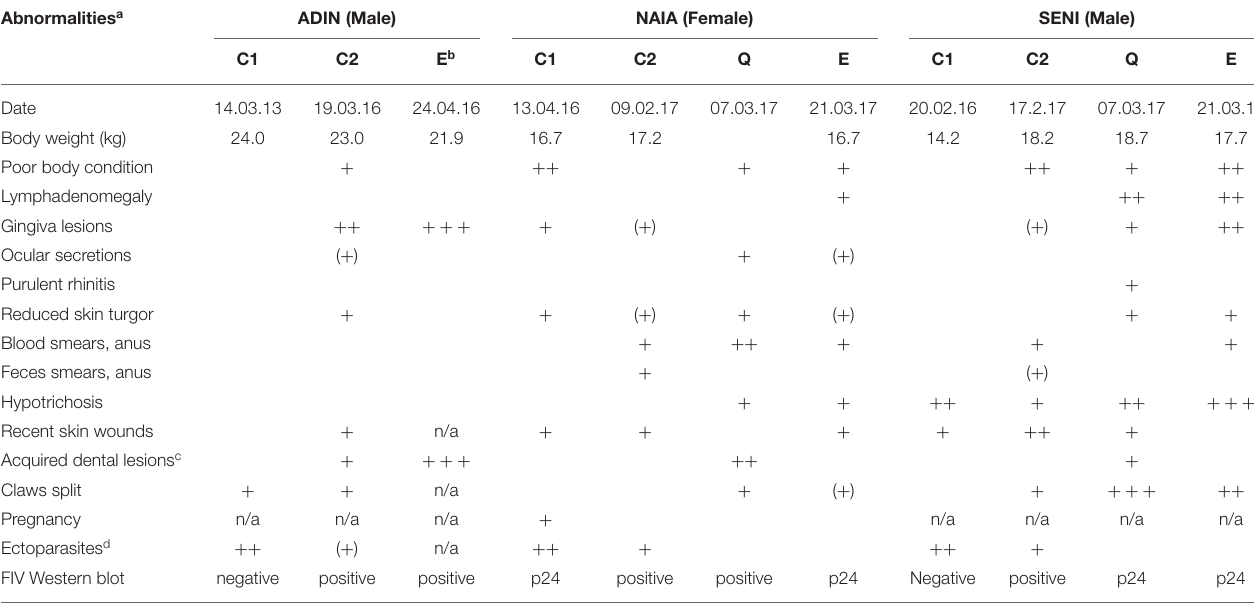
TABLE 2 | Overview of clinical findings and Western blot results at different time points of the three Eurasian lynx (Lynx lynx) seropositive for feline immunodeficiency virus: 1 st field capture (C1), 2 nd field capture (C2), during quarantine (Q), and before euthanasia (E). Empty cells: not detected. Abnormalities